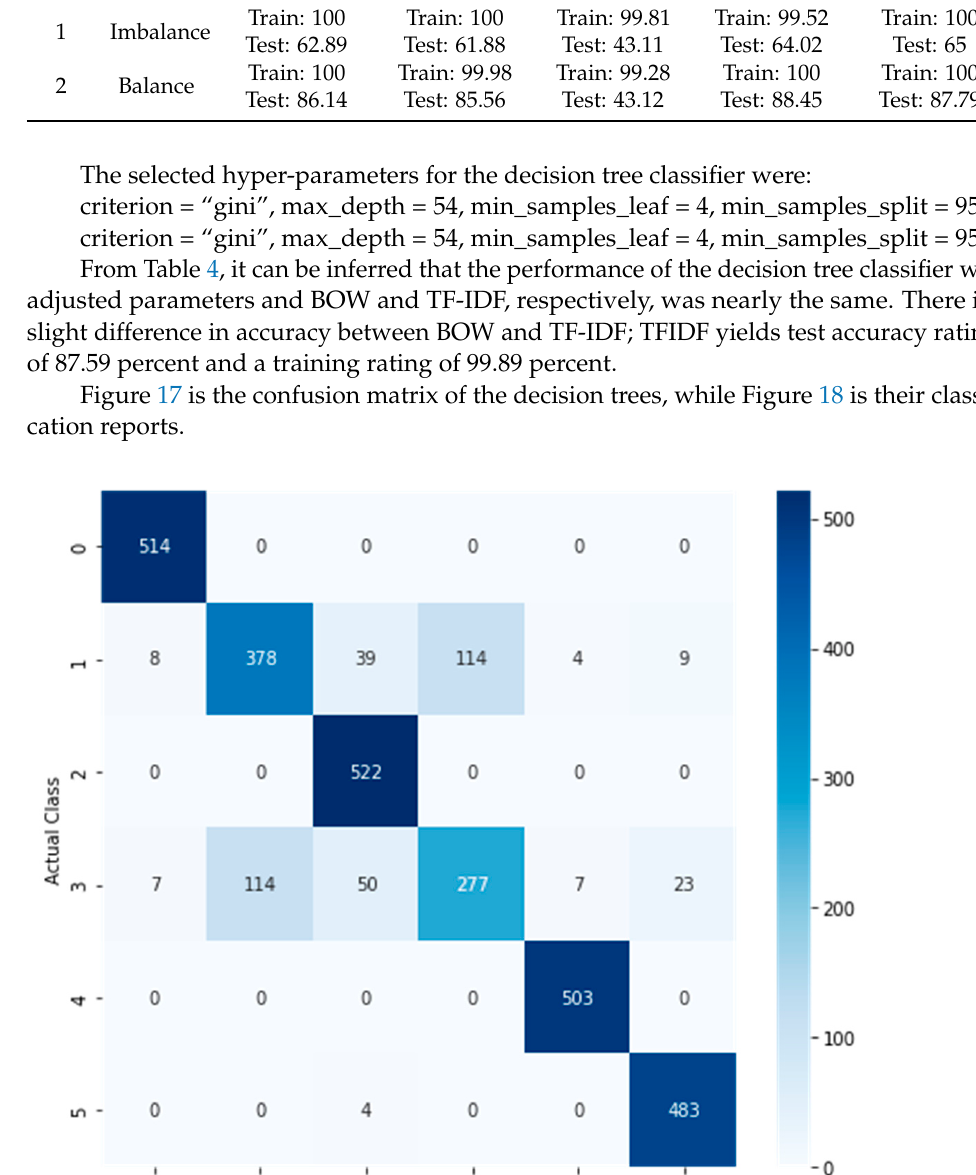
Figure 18. Classification Report of the decision tree. The generalized trained model is not overfitting or underfitting at all, according to the F1 score. The precision of all classes is between 71 and 98 percent, according to the categorization reports below, while classes 4 have 100% recall, which is considered a good rating. Nearly all classes contributed equally to the instruction [26]. The broad category of ensemble-based learning techniques includes random forest classifiers. They are incredibly effective across many domains, easy to adopt, and quick to use. The main idea behind the random forest method entails building a lot of “ simple ” decision trees during training and using a majority vote (mode) across them for classification [27]. This voting method corrects the unfavourable tendency of decision trees to overfit training data, among other things. Random forests apply the general